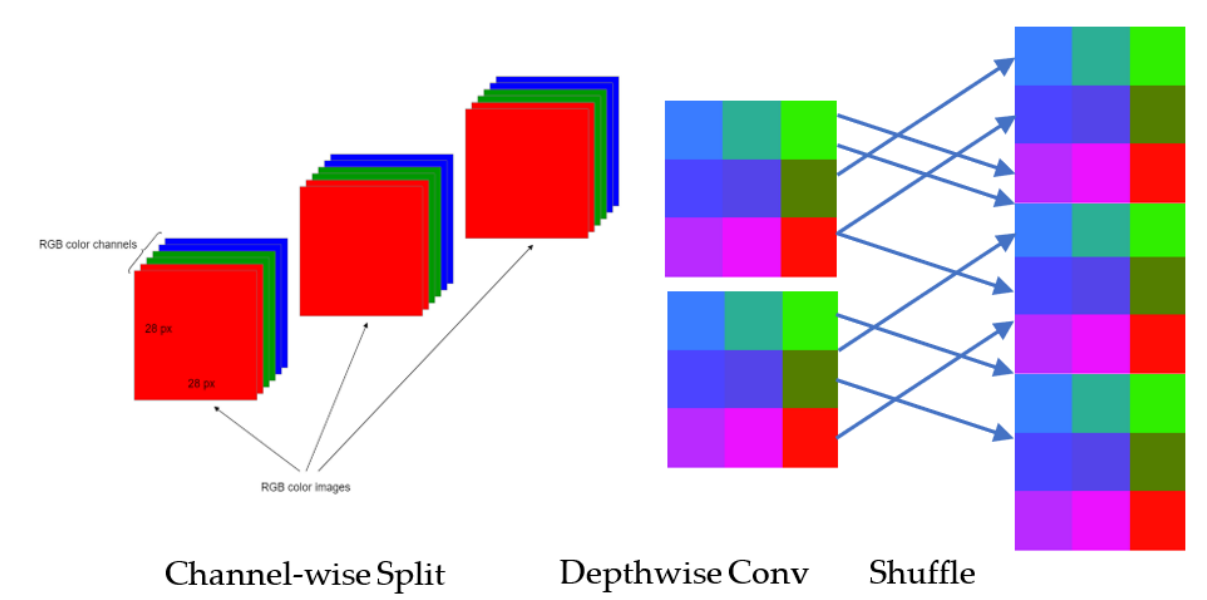
Figure 8. A visual demonstration of the channel-wise shuffle operation.